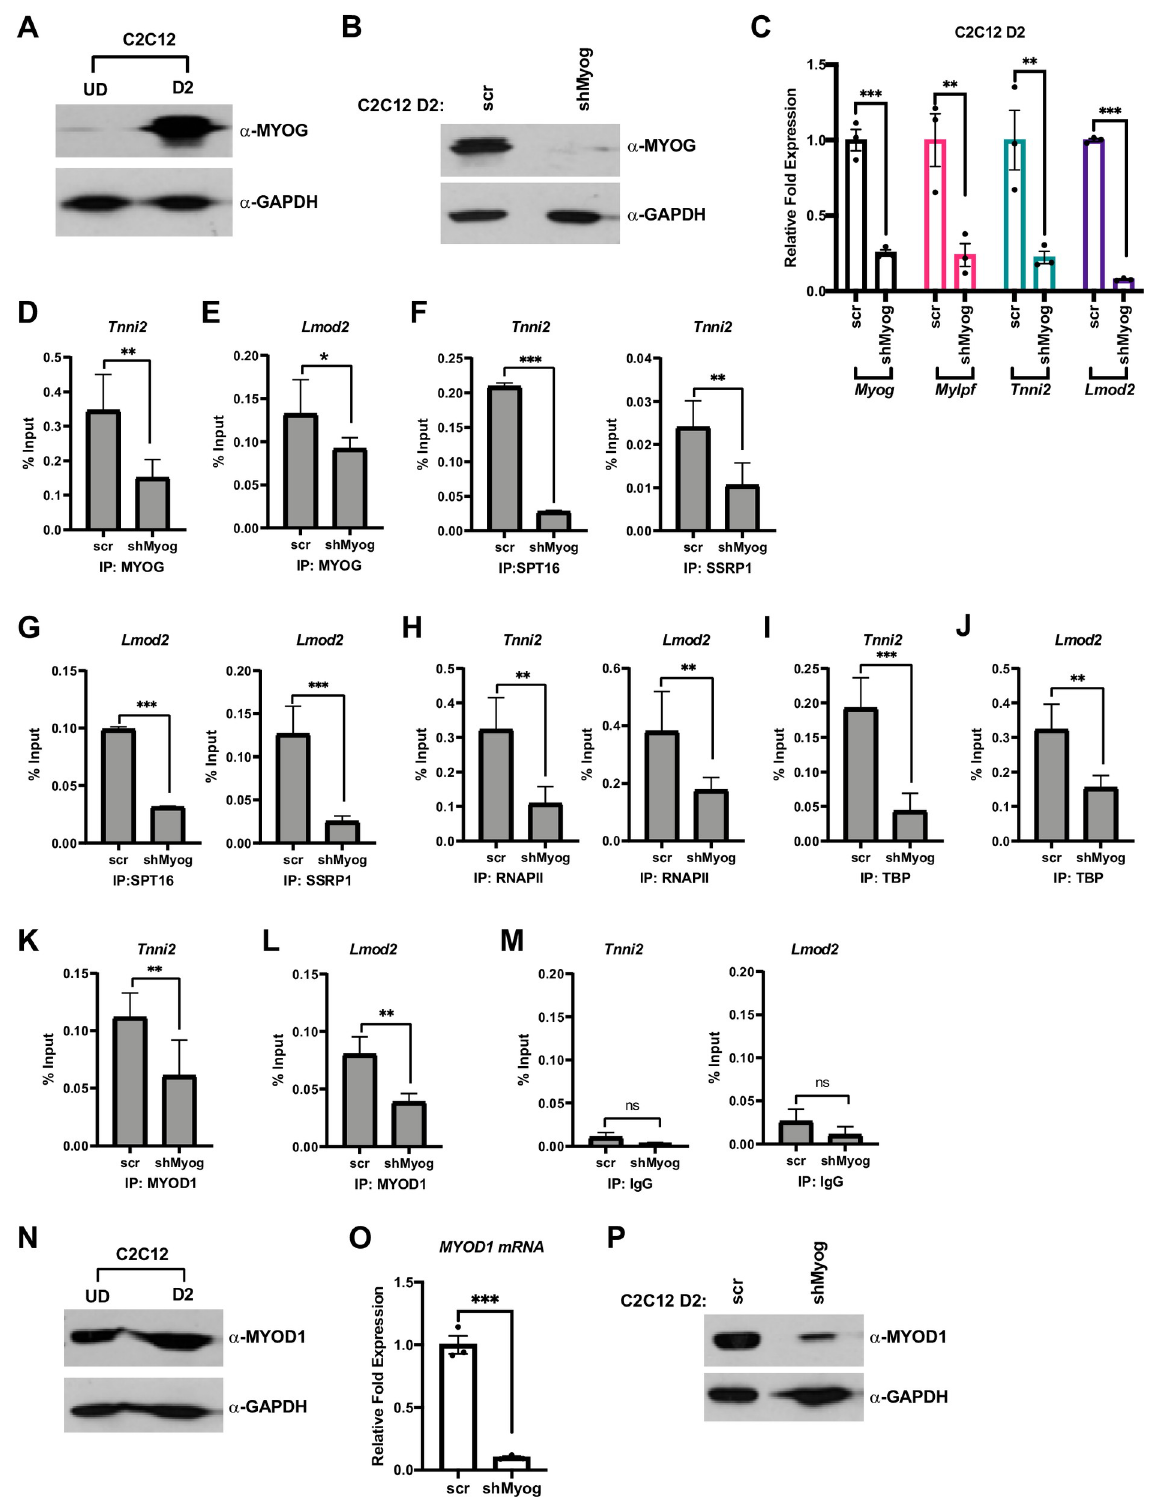
Fig 3. MYOG assembles the transcription machinery at muscle gene promoters. A. C2C12 myoblasts were grown in proliferating condition (U.D.) and differentiated for two days (D2) and were assayed for the expression of MYOG by western blot. GAPDH was used as a loading control. B. C2C12 cells were stably transfected with shRNA constructs targeting Myog (shMyog) or scrambled control (scr). The selected